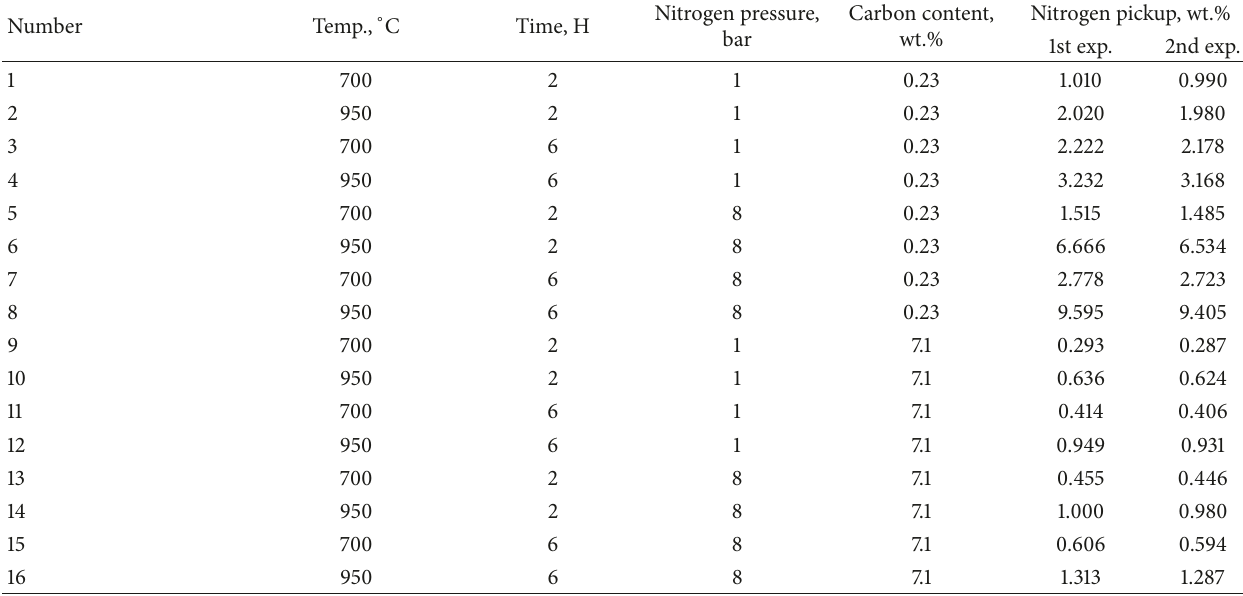
Number Temp., ∘ C Time, H